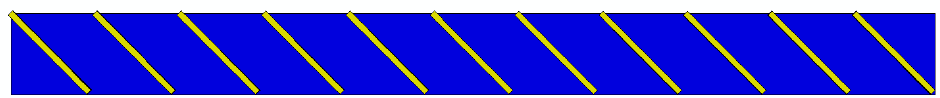
Figure 15. Configuration of the rectangular paper sheet with patterned oblique beams.